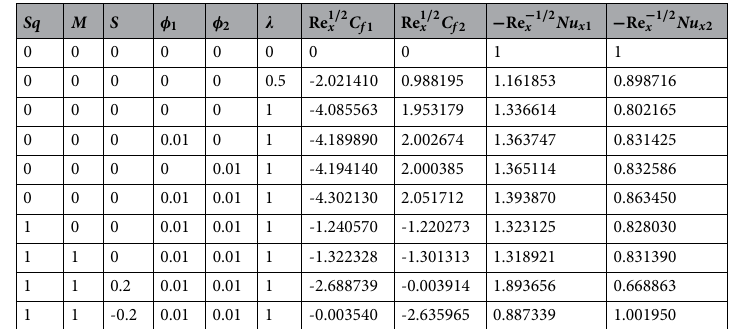
1 / 2 Re − 1 / 2 Re 1 / 2 x Nu x 1 and − x C f 1 , x C f 2 , −